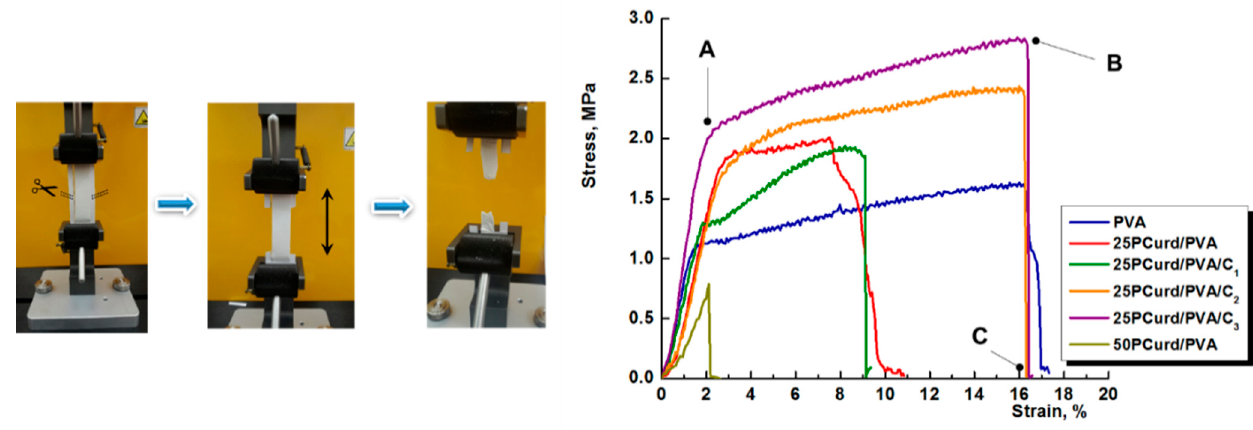
Figure 4. Stress–strain tensile curves for PVA and PCurd/PVA nanofibre membranes with and without CEO.